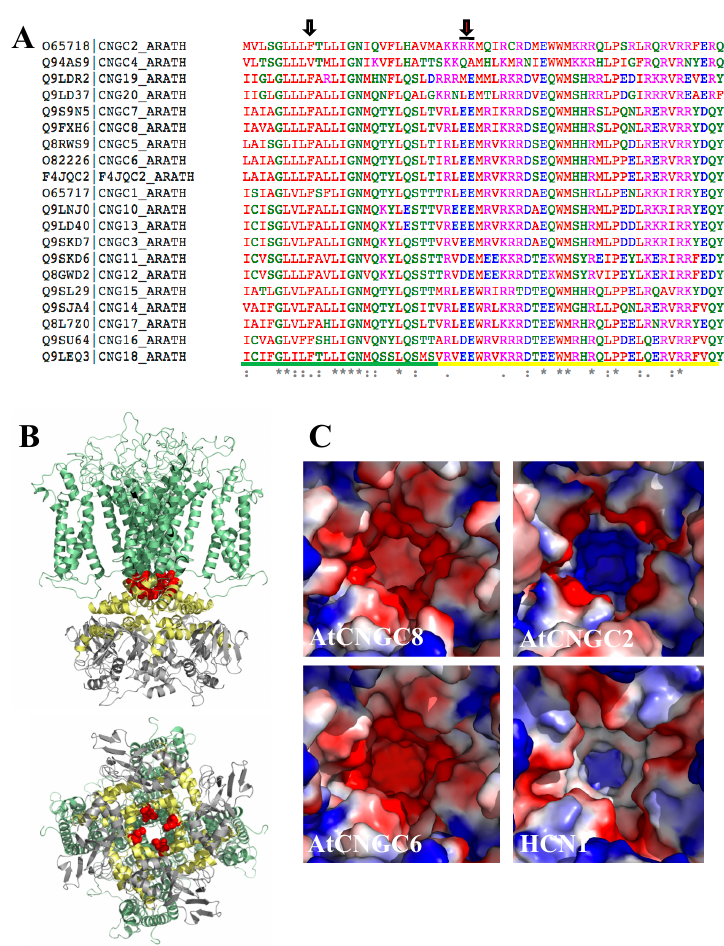
Figure 8. Structural rationale for the channel-blocking e ff ect of Mg 2 + . ( A ) Sequence alignment of the AtCNGC protein sequence surrounding the putative Mg 2 + binding site. The diacidic motif present in most AtCNGCs is highlighted by a red arrow and black line, whereas the location corresponding to the Mg 2 + binding acidic motif in the K ir 2.2 pore domain is indicated by the left arrow (grey filling). The residues of the pore and linker regions are underlined in green and yellow, respectively. ( B ) Structural model of AtCNGC8 based on human HCN1 (PDB accession number 5u6o; for the sequence: see Figure S2A). Top panel: side view, with the transmembrane region colored in green, the linker region in yellow, and the cytoplasmic cAMP binding domain in grey. The diacidic motifs (residues E437 and E438 in AtCNGC8) are highlighted as red sphere models. Bottom panel: view from the cytoplasm into the channel (90 ◦ rotation with respect to top panel). ( C ) Electrostatic surface representation (color-ramped from negatively charged in red to positively charged in blue) of homology models of AtCNGCs containing the diacidic motif (AtCNGC8 and 6) and of AtCNGC2 (model) and human HCN1 (PDB 5u6o) lacking this motif.